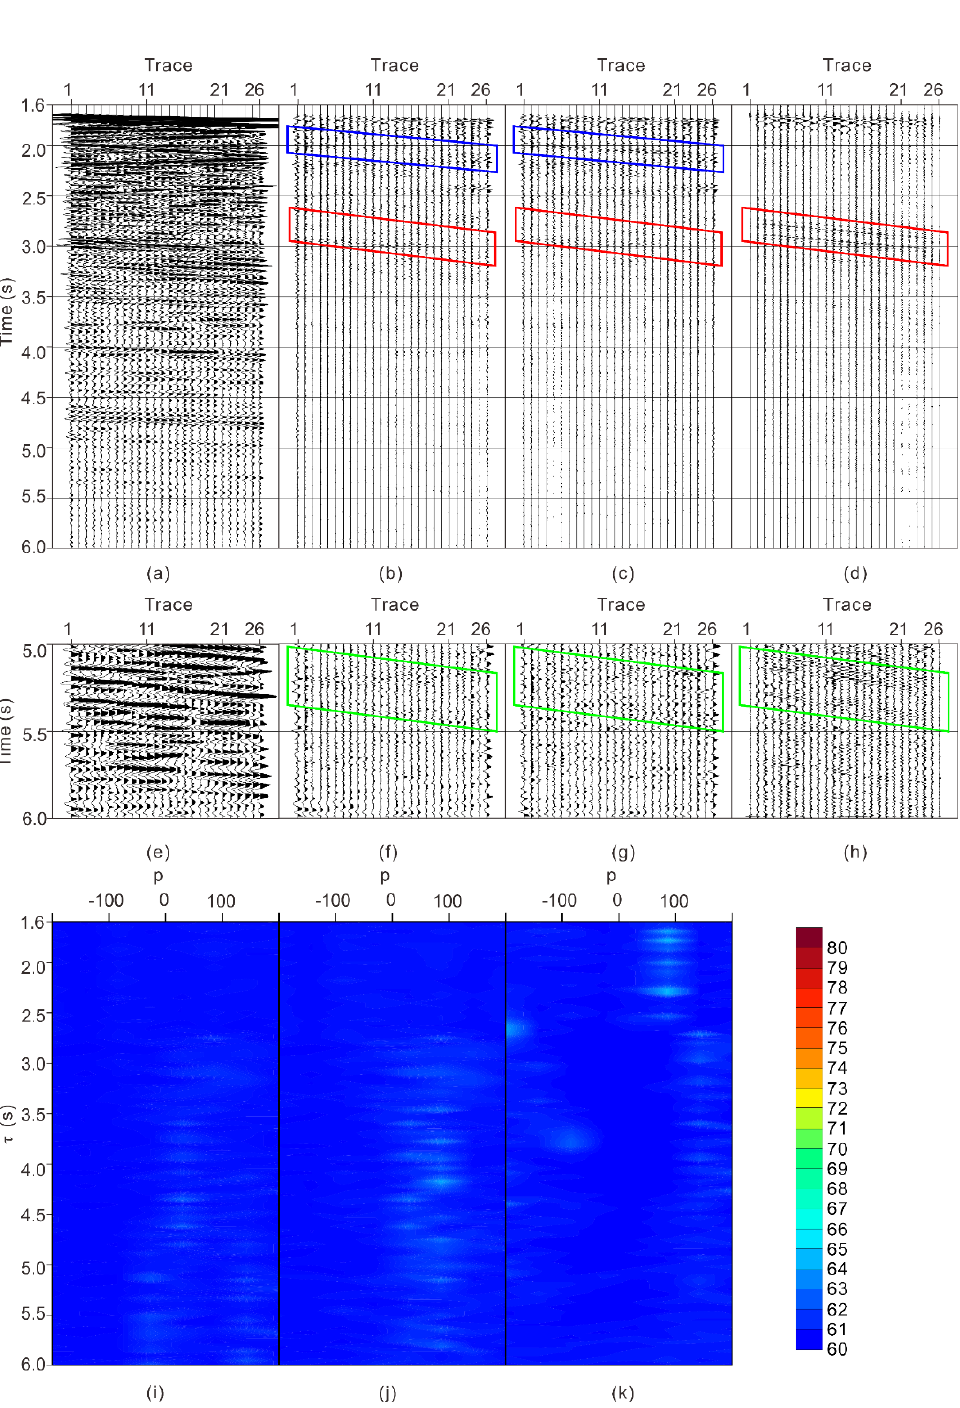
Figure 16. Residual wavefield after subtraction of four wavefields. ( a ) Original VSP data; ( b ) Residual wavefield using our method; ( c ) Residual wavefield using traditional median filtering; ( d ) Residual wavefield using the high-resolution Radon transform; ( e – h ) are zoomed versions of ( a – d ), respectively; ( i ) Slowness spectrum of ( b ); ( j ) Slowness spectrum of ( c ); ( k ) Slowness spectrum of ( d ).